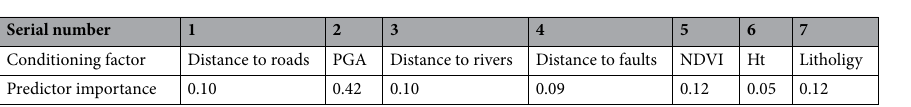
Table 4. The importance of conditioning